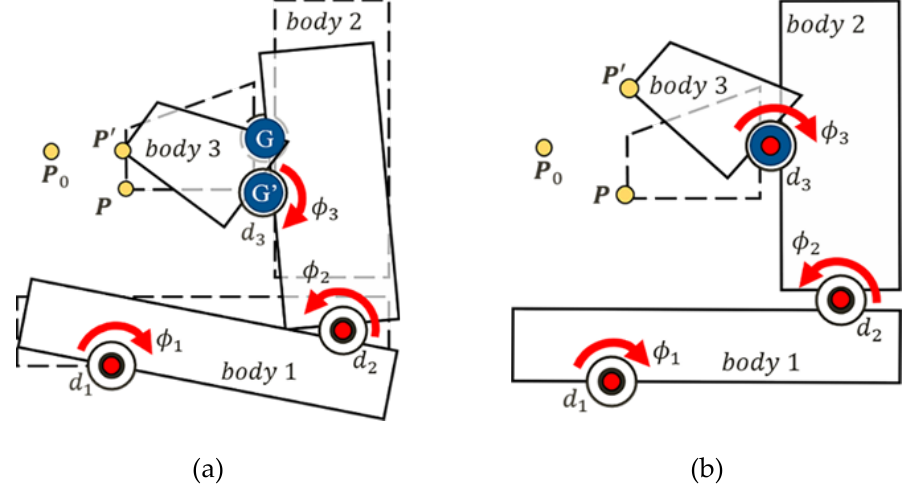
Figure 6. Canceling the former transformation: ( a ) mode shape before cancelation; ( b ) mode shape after cancelation.